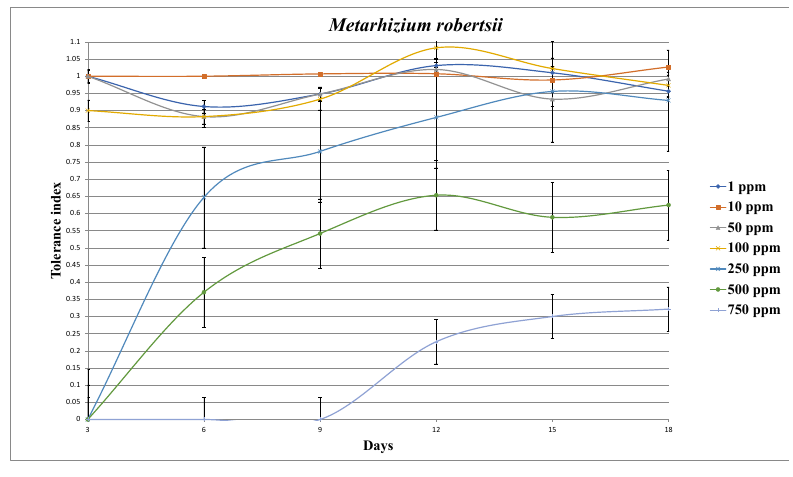
Fig. 4 Effect of an increasing Sn 2+ concentration on the tolerance index of Metarhizium robertsii over an 18-day incubation period.